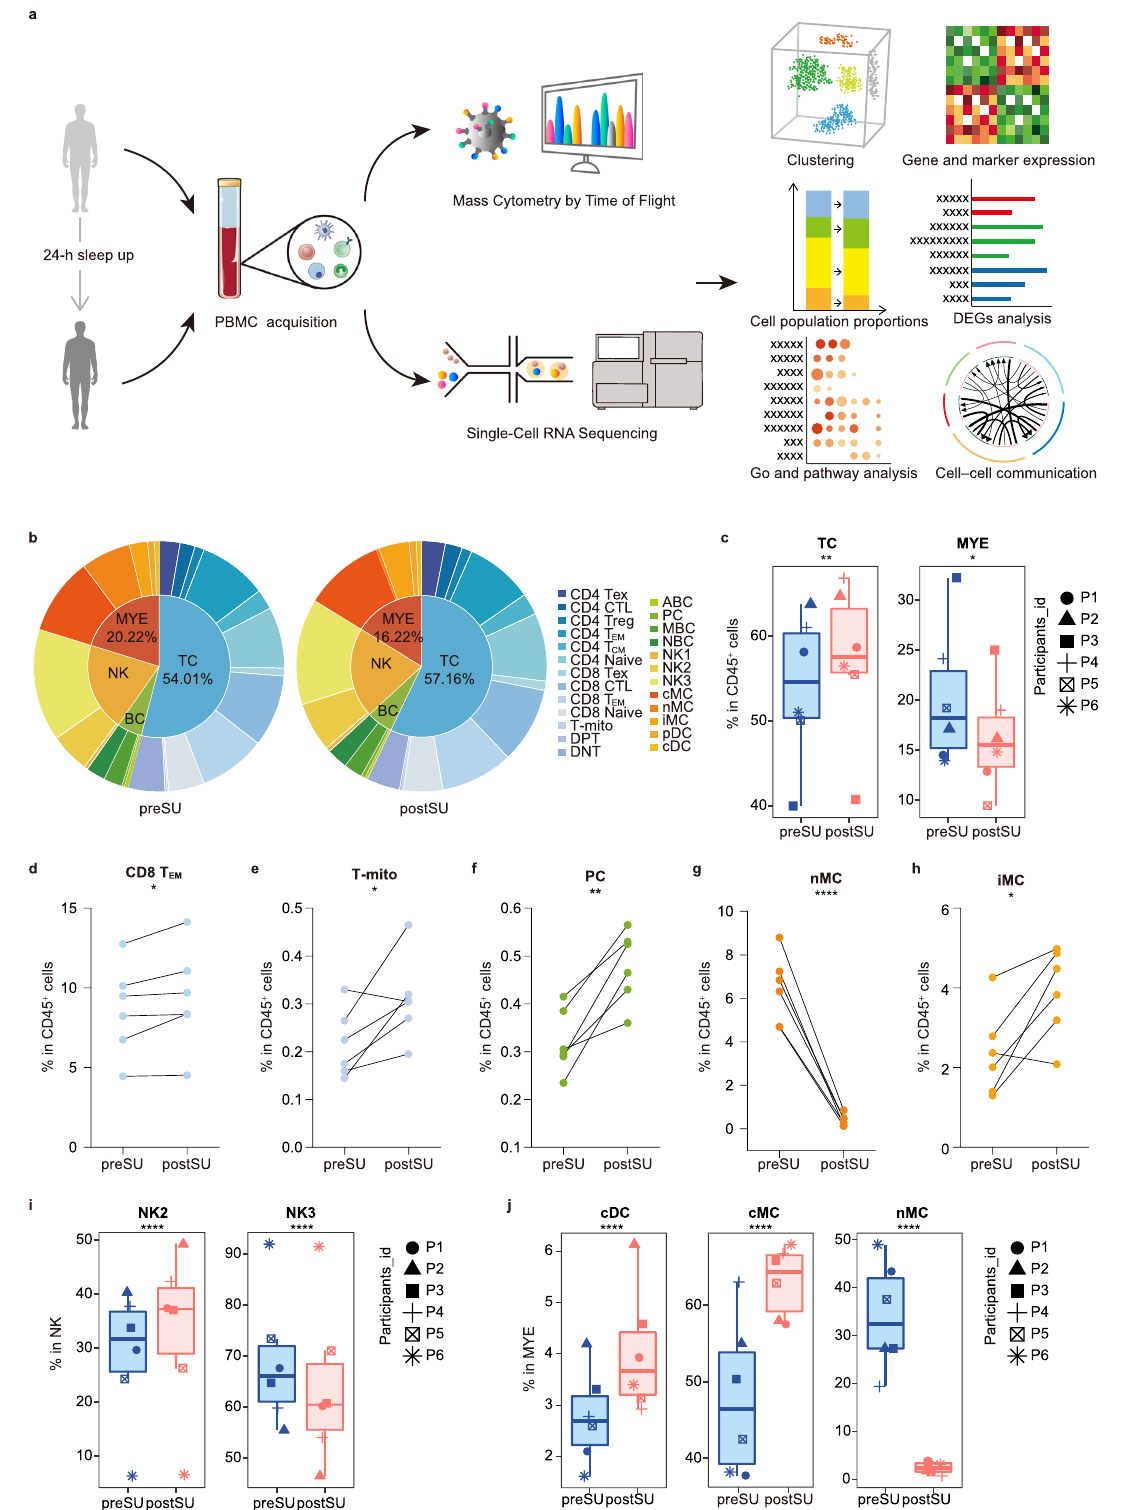
Fig. 1 The experimental design and changes in cell proportions after SU. a Schematic of the experimental design for mass cytometry by time of fl ight (CyTOF) and single-cell RNA sequencing (scRNA-seq). Peripheral blood mononuclear cells (PBMCs) of six healthy individuals were collected before and post the 24-h sleep loss, then processed CyTOF and scRNA-seq for the subsequent studies. b Pie charts showing relative cluster abundance in the preSU and postSU groups. The percentage of TC and MYE ( c ), CD8 T EM ( d ), T-mito ( e ), PC ( f ), nMC ( g ) and iMC ( h ) in CD45 + immune cell between preSU and postSU groups ( n = 6 /group). i The percentage of NK2 and NK3 subsets in NK between preSU and postSU groups ( n = 6 /group). j The percentage of cMC, nMC and cDC in MYE between preSU and postSU groups ( n = 6 /group). Signi fi cance in d – h was calculated using two-tailed paired t -test; signi fi cance in c , i and j was calculated using the “ diffcyt-DA-GLMM ” method as implemented in the “ diffcyt ” function in view of the subjects pairing; * P < 0.05, ** P < 0.01, **** P < 0.0001. The full names of the 25 cell types in CyTOF see Supplementary Fig. 1. COMMUNICATIONS BIOLOGY| (2021) 4:1325